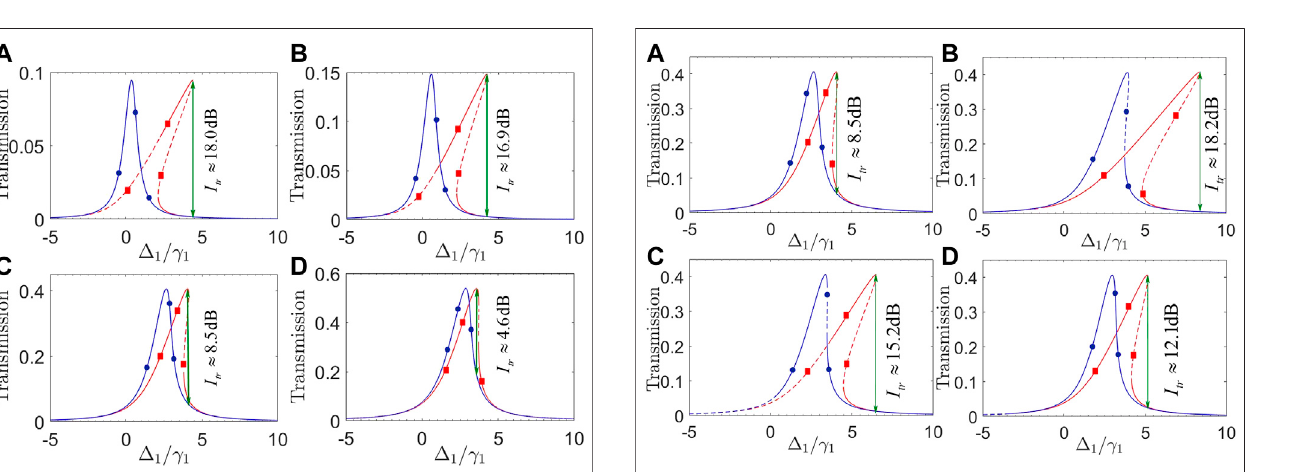
FIGURE 7 | (Color online) Transmission coef fi cients T 31 (red squares) FIGURE 6 | (Color online) Transmission coef fi cients T 31 (red squares) and T 13 (blue circles) against detuning Δ 1 with (A) g /2 π (cid:1) 0.9 MHz; (B) g /2 π (cid:1) and T 13 (bluecircles)againstdetuning Δ 1 with (A) J 12 /2 π (cid:1) 1.0 GHz; (B) J 12 /2 π 1.6 MHz; (C) ω m /2 π (cid:1) 4.5 GHz; (D) ω m /2 π (cid:1) 6.5 GHz. Solid and dashed parts (cid:1) 1.3 GHz; (C) J π (cid:1) 1.0 GHz; (D) J π (cid:1) 1.3 GHz. Solid and dashed 23 /2 23 /2 of each curve refer to stable and unstable regions, respectively. Other parts of each curve refer to stable and unstable regions, respectively. parameters are the same as in Figure 5 , except p in (cid:1) 20 Other parameters are the same as in Figure 5 , except p in (cid:1) 20 mW.